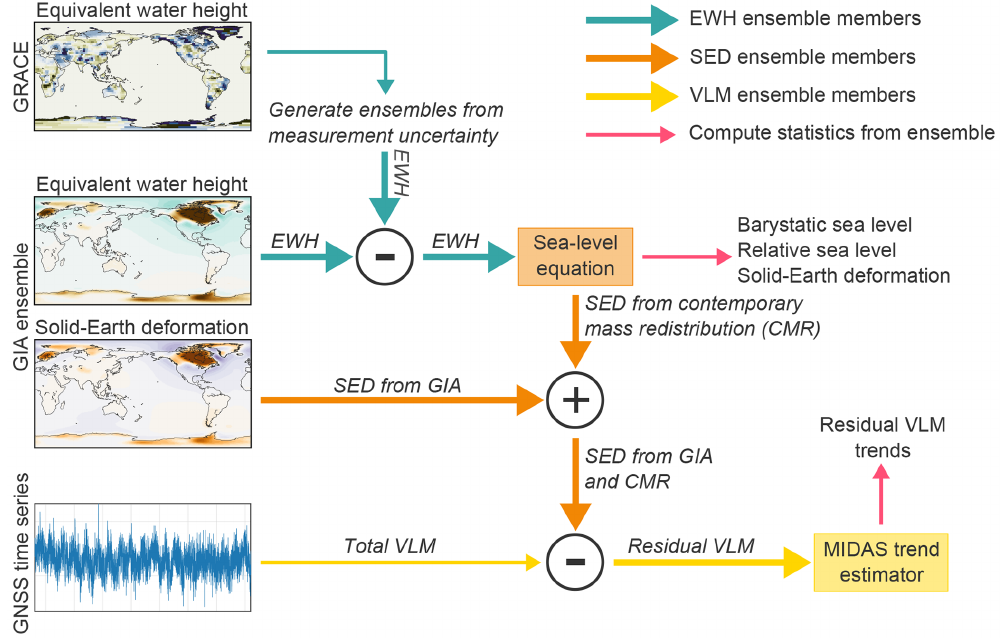
Figure 1. Overview of the processing steps taken to compute trends in residual VLM from the GRACE observations, GNSS time series, and GIA estimates. Thick arrows denote ensemble computations, while thin lines denote non-ensemble